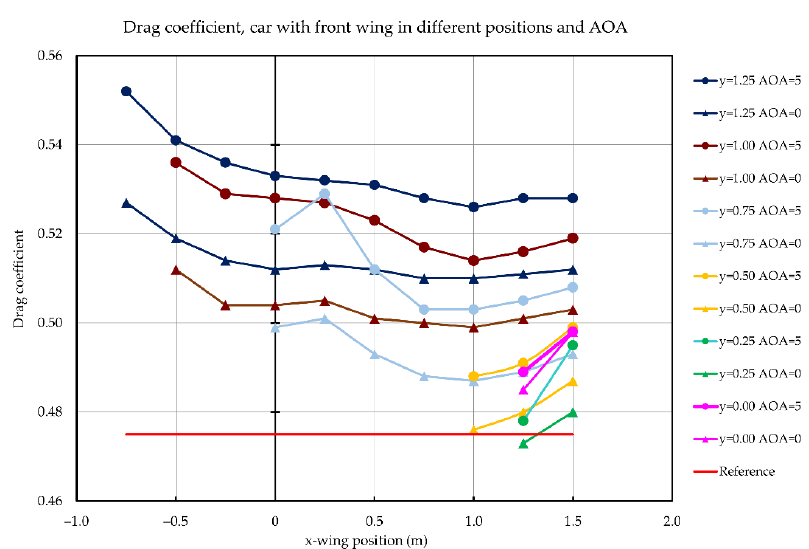
Figure 23. Changes in the lift force acting on the vehicle as a function of the wing position relative to the body and depending on the angle of attack (AOA).